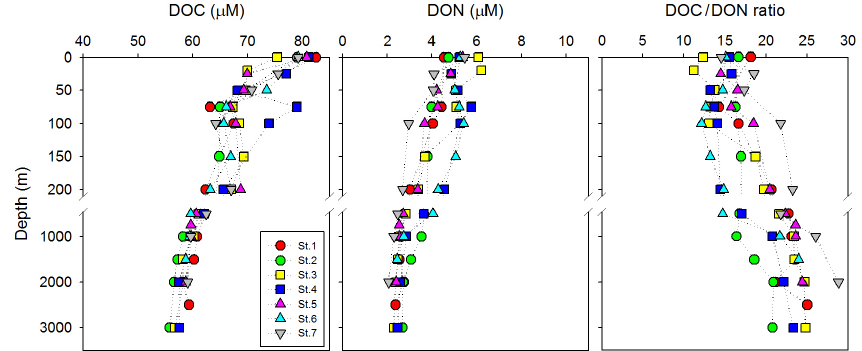
Figure 2. Vertical profiles of dissolved organic carbon (DOC), dissolved organic nitrogen (DON), and the DOC:DON ratio in the East/Japan